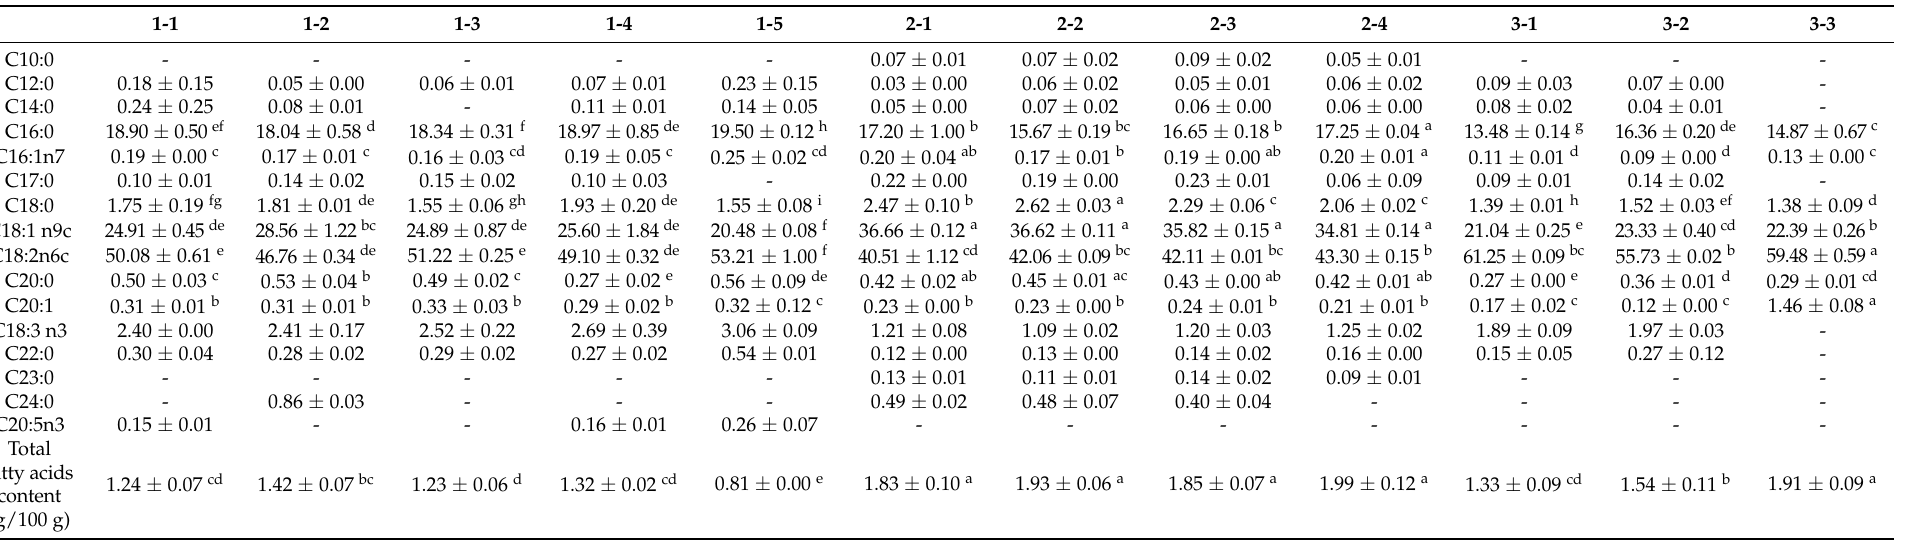
Table 3. Relative fatty acid contents of fresh sweet-waxy corn from the three producing provinces (% of total fatty acids).